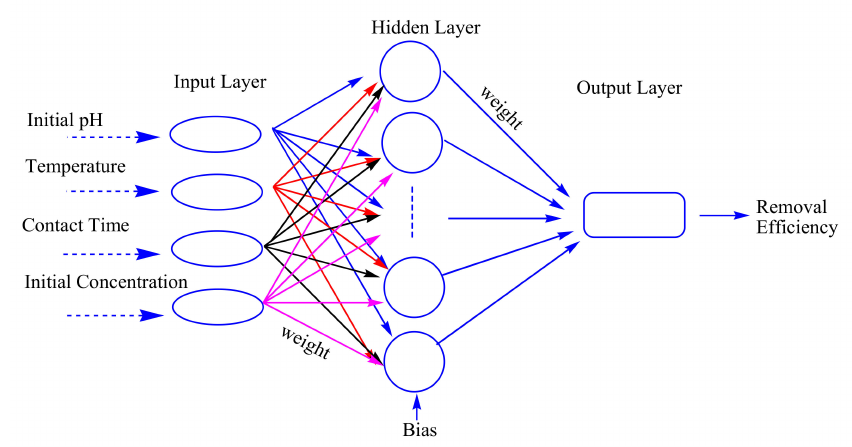
Figure 2. Illustration of Back Propagation Artificial Neural Network (BP-ANN)